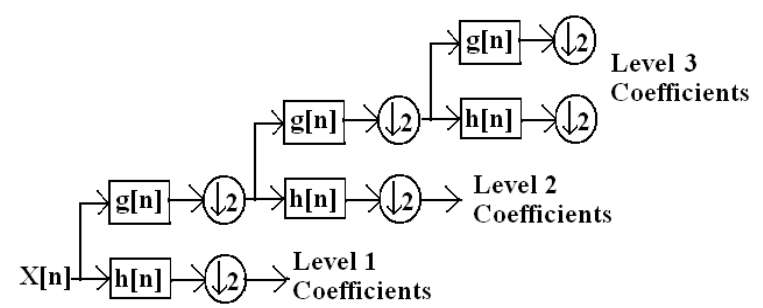
Figure 2. Discrete wavelet transform